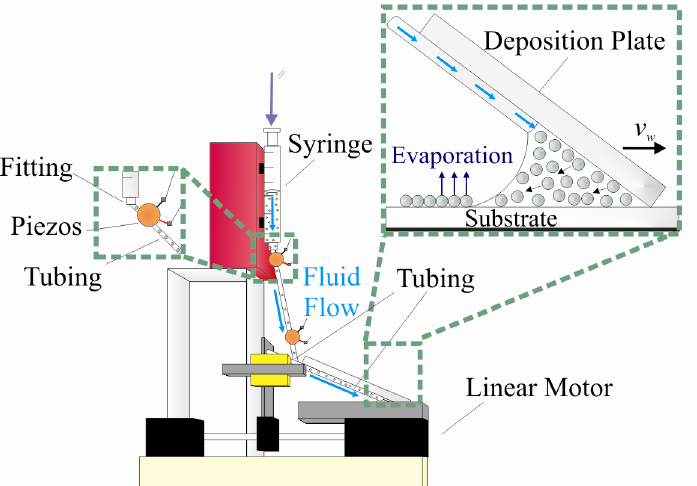
Figure 9. Schematic of the continuous convective assembly coating apparatus. The fluid delivery system pumps the suspension from the fluid reservoir (syringe) to the interface between the deposition plate and substrate. Underside delivery system